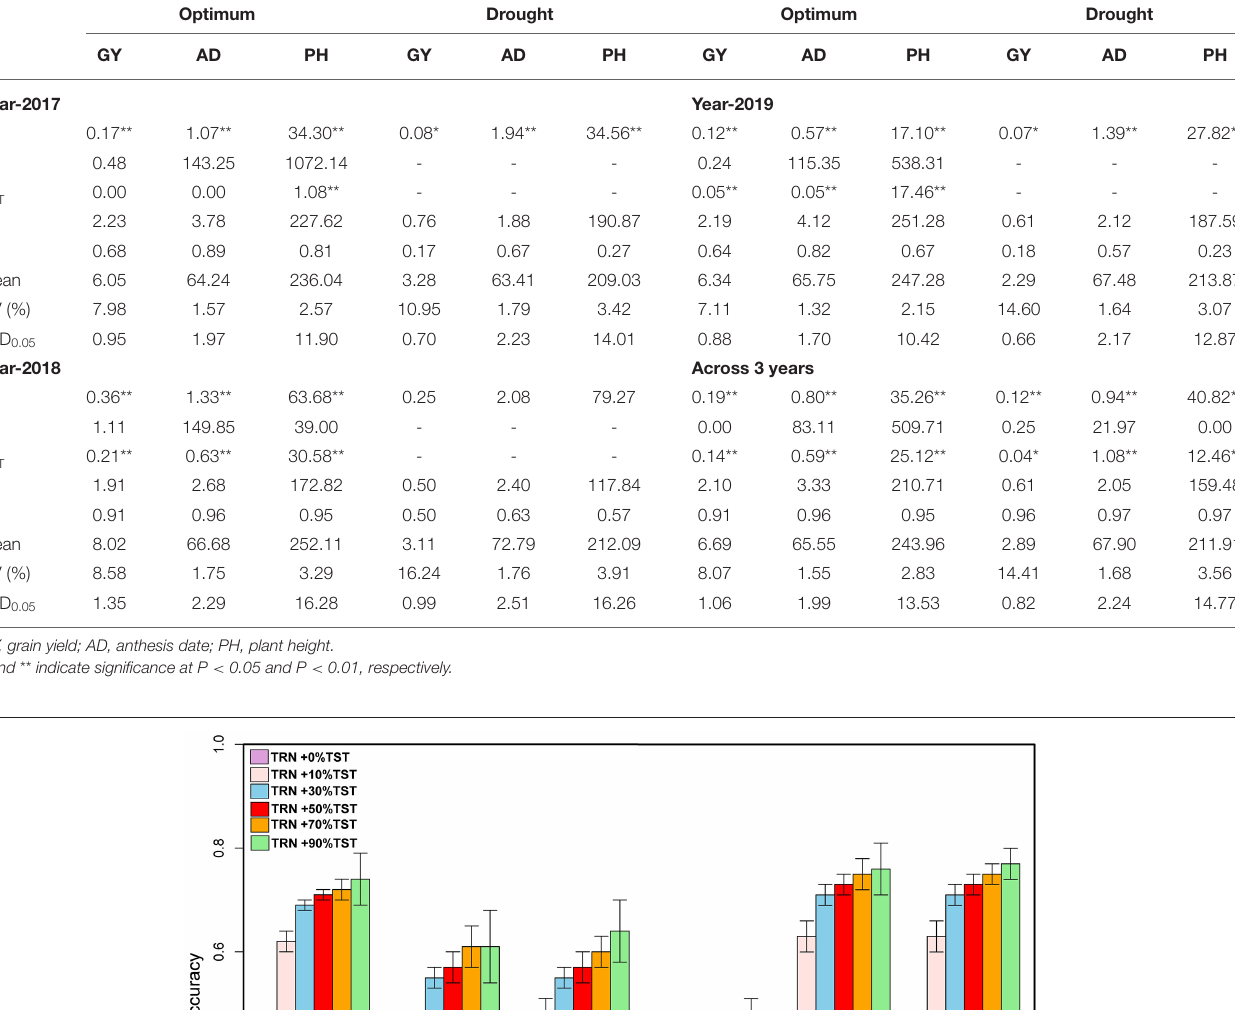
TABLE 1 | Estimation of variance components for grain yield and agronomic traits assessed in 3 years and across trials under optimum and drought conditions. Optimum Drought Optimum Drought GY AD PH GY AD PH GY AD PH GY AD